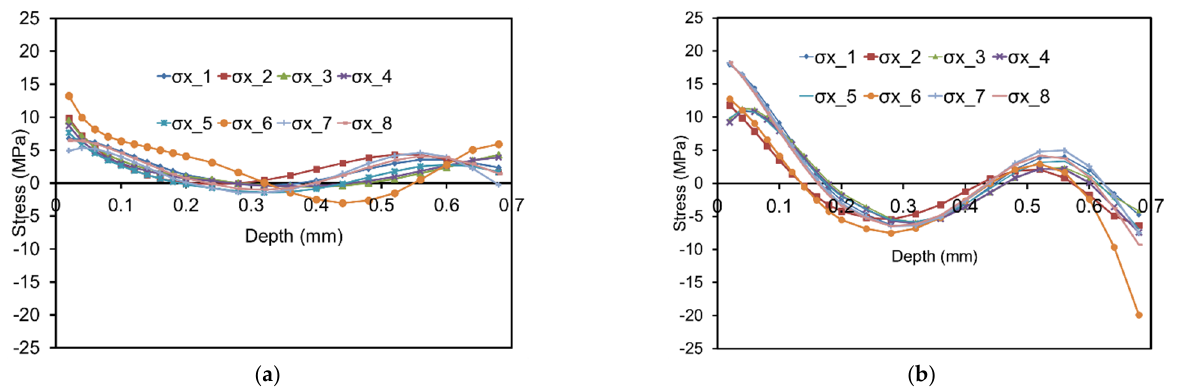
Figure 17. Effect of drilling speed on the resulting residual stresses considering ( a ) fast and ( b ) slow drilling. For better resolution of results scales are different.